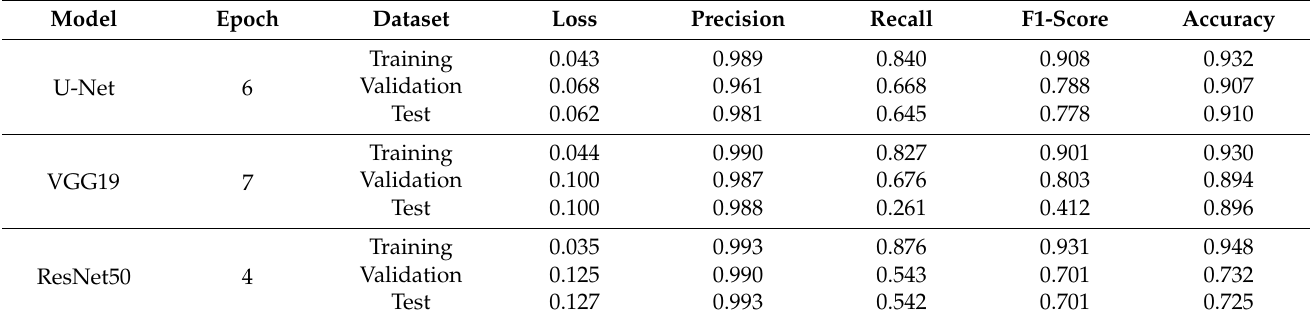
Table 4. Metrics of the best-performing models according to the F1-scores for the validation sets (rows in bold). The datasets were split as 80-10-10% for the training, validation, and test sets,